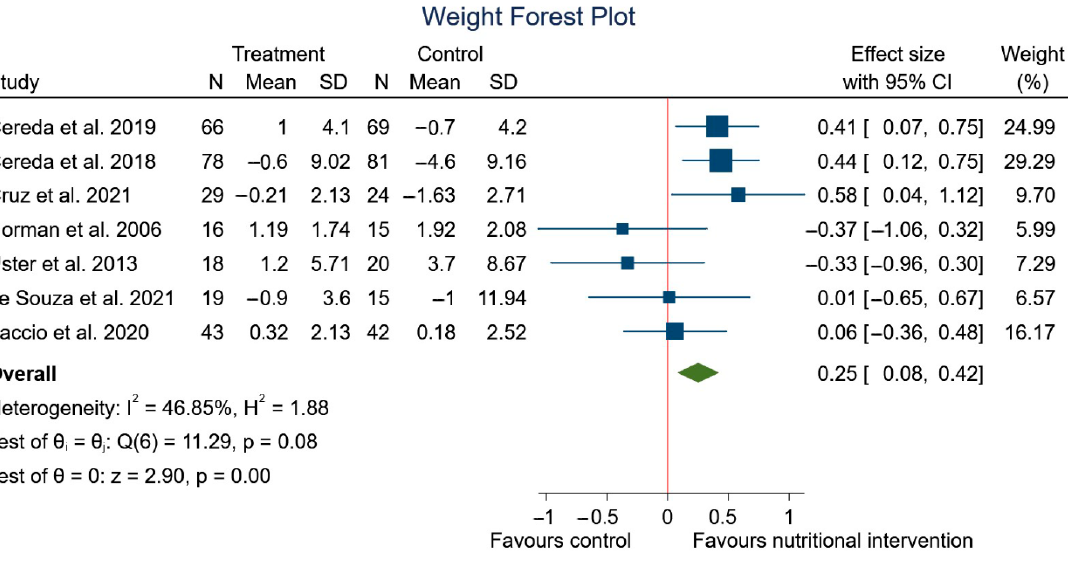
Figure 6. Forest plot summarizing the impact of nutritional intervention on weight using a fixed- effects model. Pooled summary data are presented as standardized mean differences and 95% confidence interval [39–42,52,54,55].